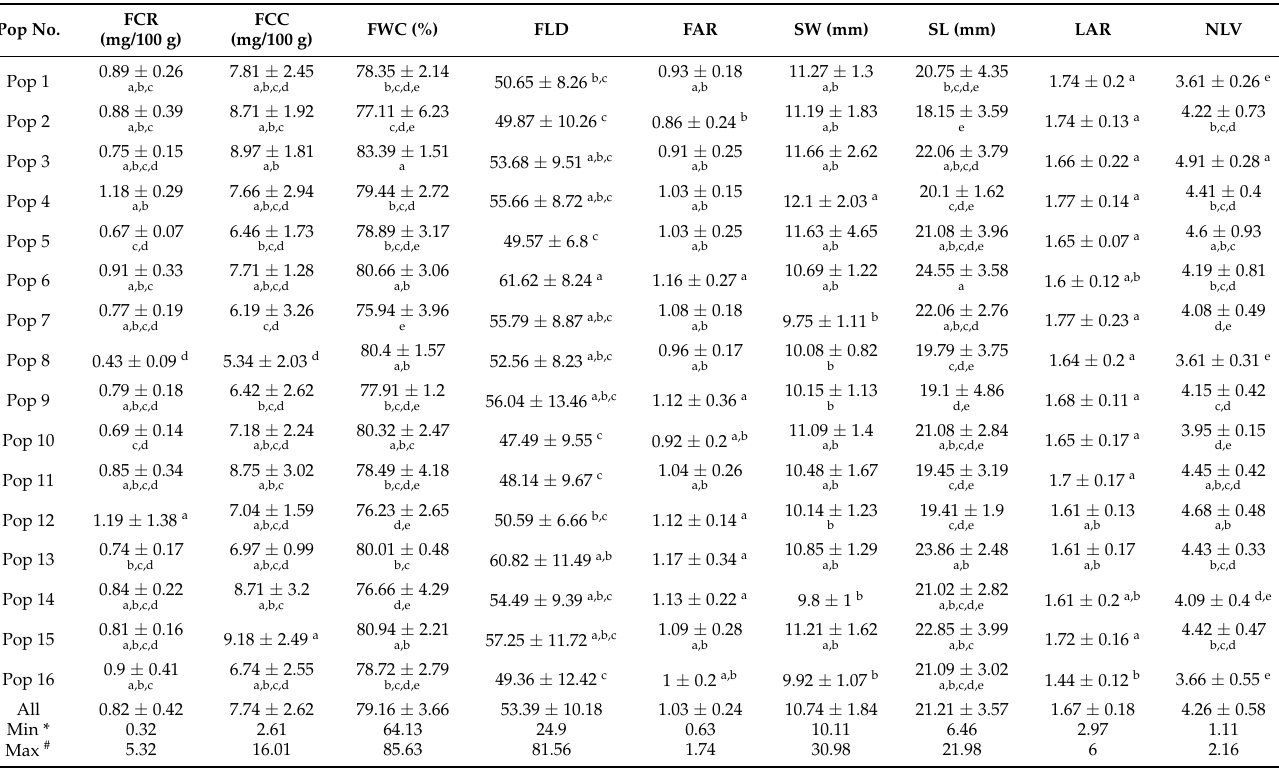
Table 2. Nine morphological traits present in persimmon germplasms.